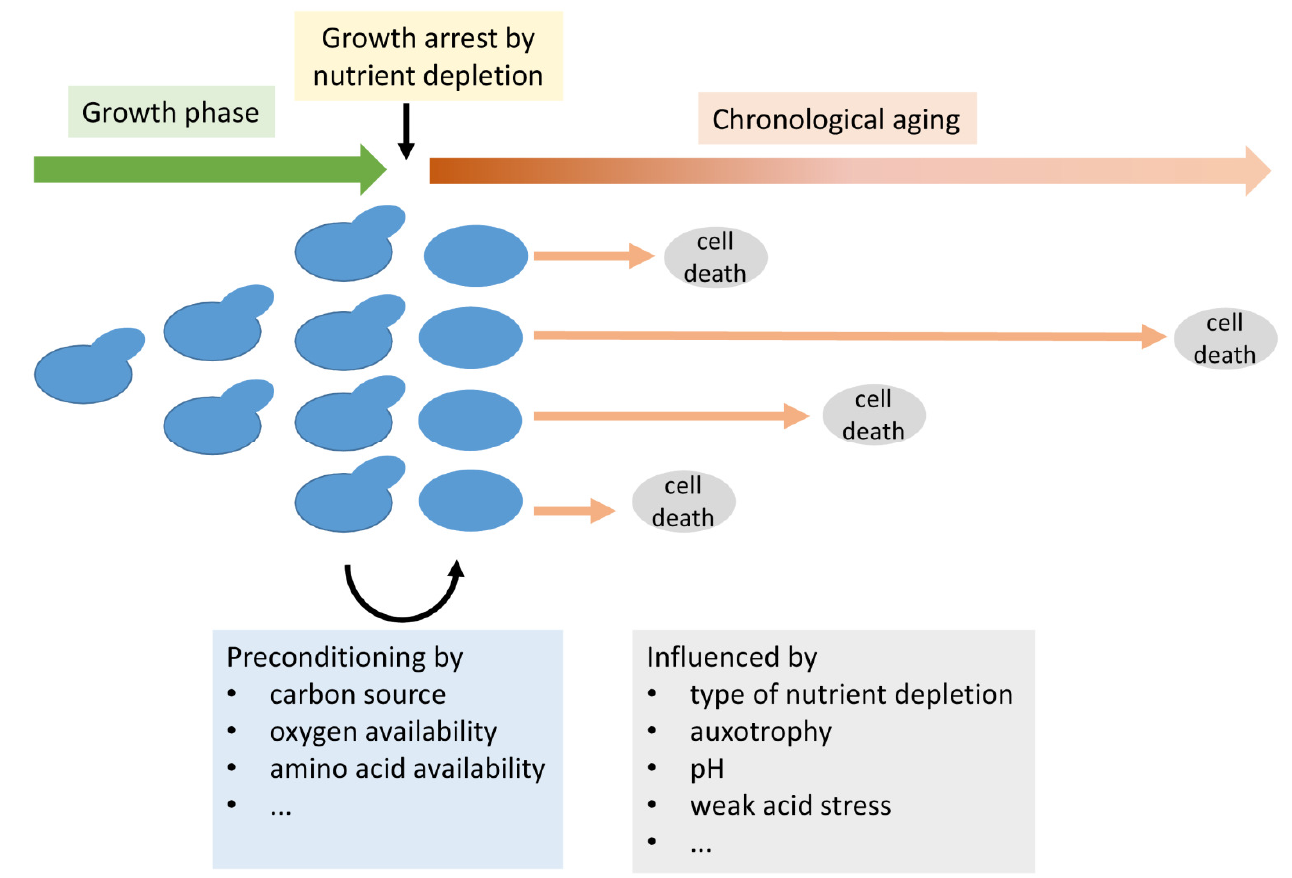
FIGURE 1: Schematic representation of growth and chronological aging of yeast cells with an indication of factors influencing the chronological